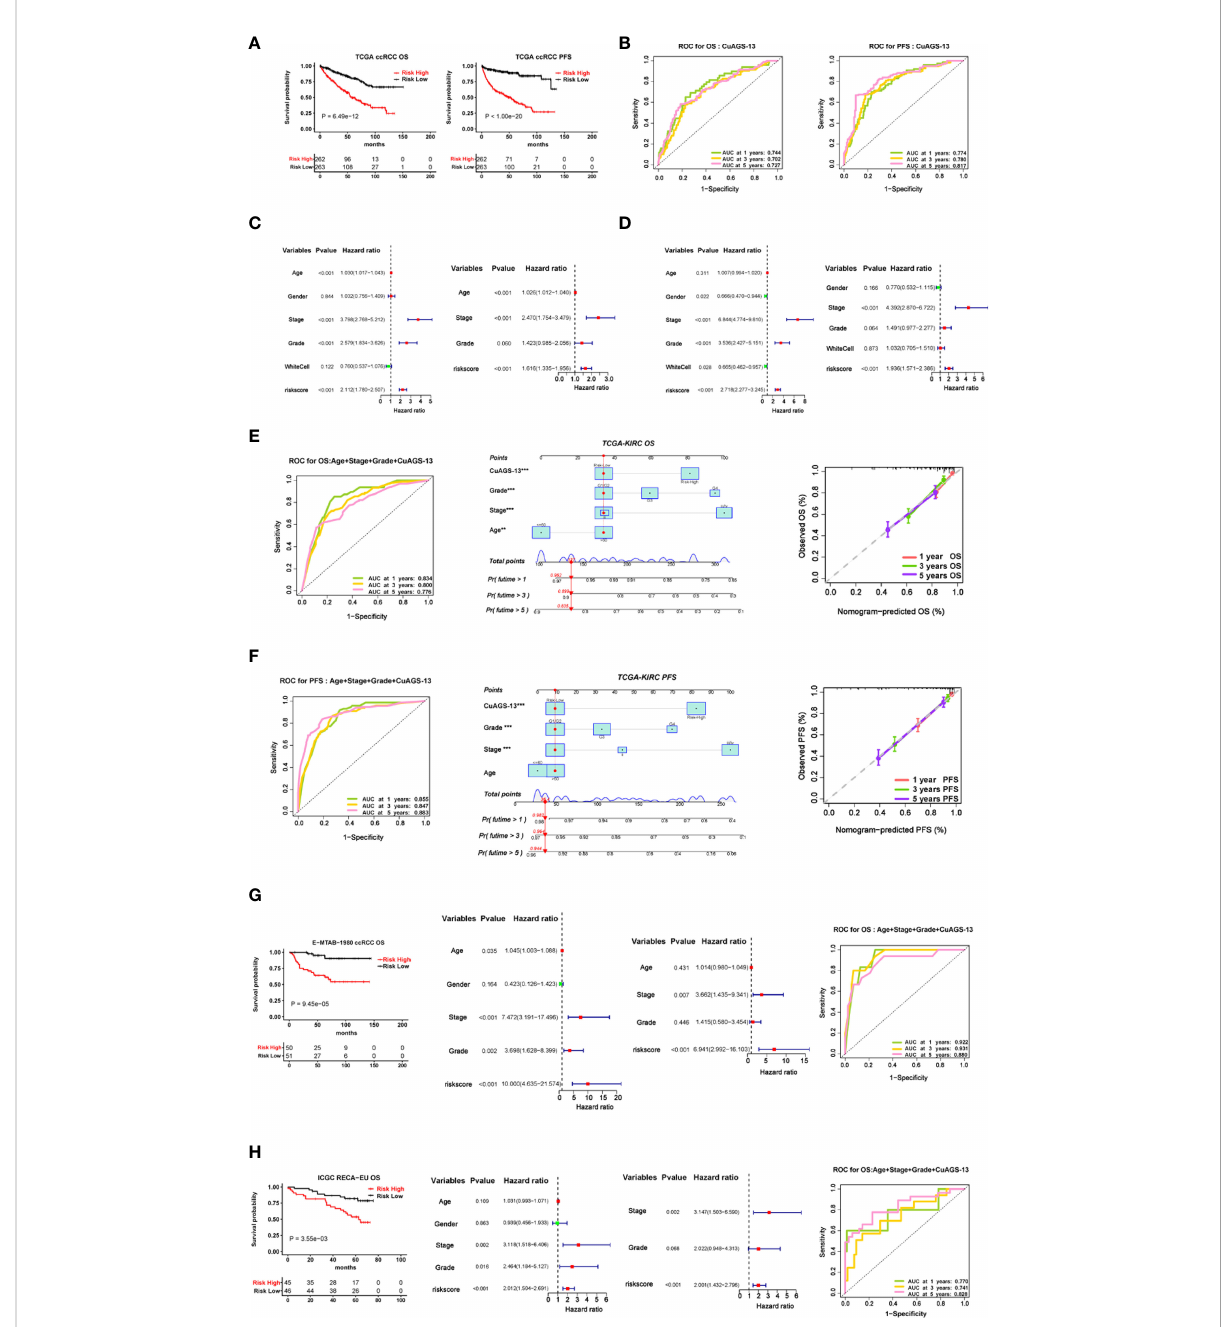
FIGURE 3 The cuproptosis-associated 13 gene signature (CuAGS-13) model for ccRCC survival prediction. (A) Kaplan – Meier survival analysis showing the signi fi cant association of the CuGAS-13 score with OS and PFS in the TCGA ccRCC cohort. Patients were classi fi ed into high- and low-risk groups based on the CuGAS-13 score using a median value as the cutoff. (B) The ROC curve showing a high accuracy in predicting 1-, 3- and 5-year OS and PFS using the CuGAS-13 model. (C) and (D) Univariate and multivariate Cox regression analyses of OS and PFS in ccRCC, respectively. (E) and (F) The nomogram composed of CuAGS-13 model, age, grade and stage for predicting 1-, 3- and 5-year OS and PFS, respectively. (G) The validation of the CuGAS-13 model for the prediction of OS in the EMBA-1980 cohort of ccRCC. (H) The validation of the CuGAS-13 model for the prediction of OS in the ICGC-RECA-EU cohort of